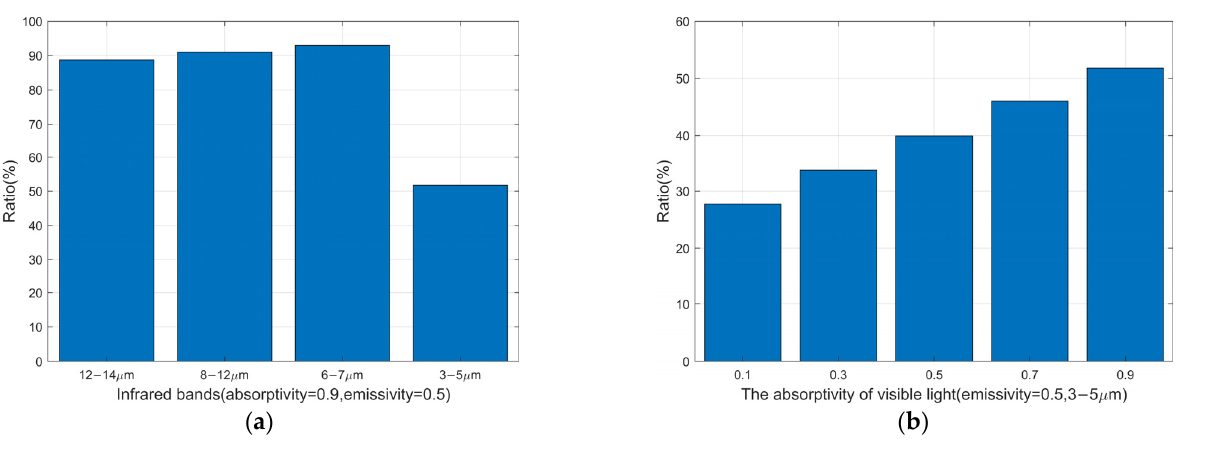
Figure 3. Temperature and emissivity-area product error percentage and RMSE ( ϵ = 0.5) ( a ) temperature error percentage ( b ) temperature RMSE ( c ) emissivity-area product error percentage ( d ) emissivity-area product RMSE.